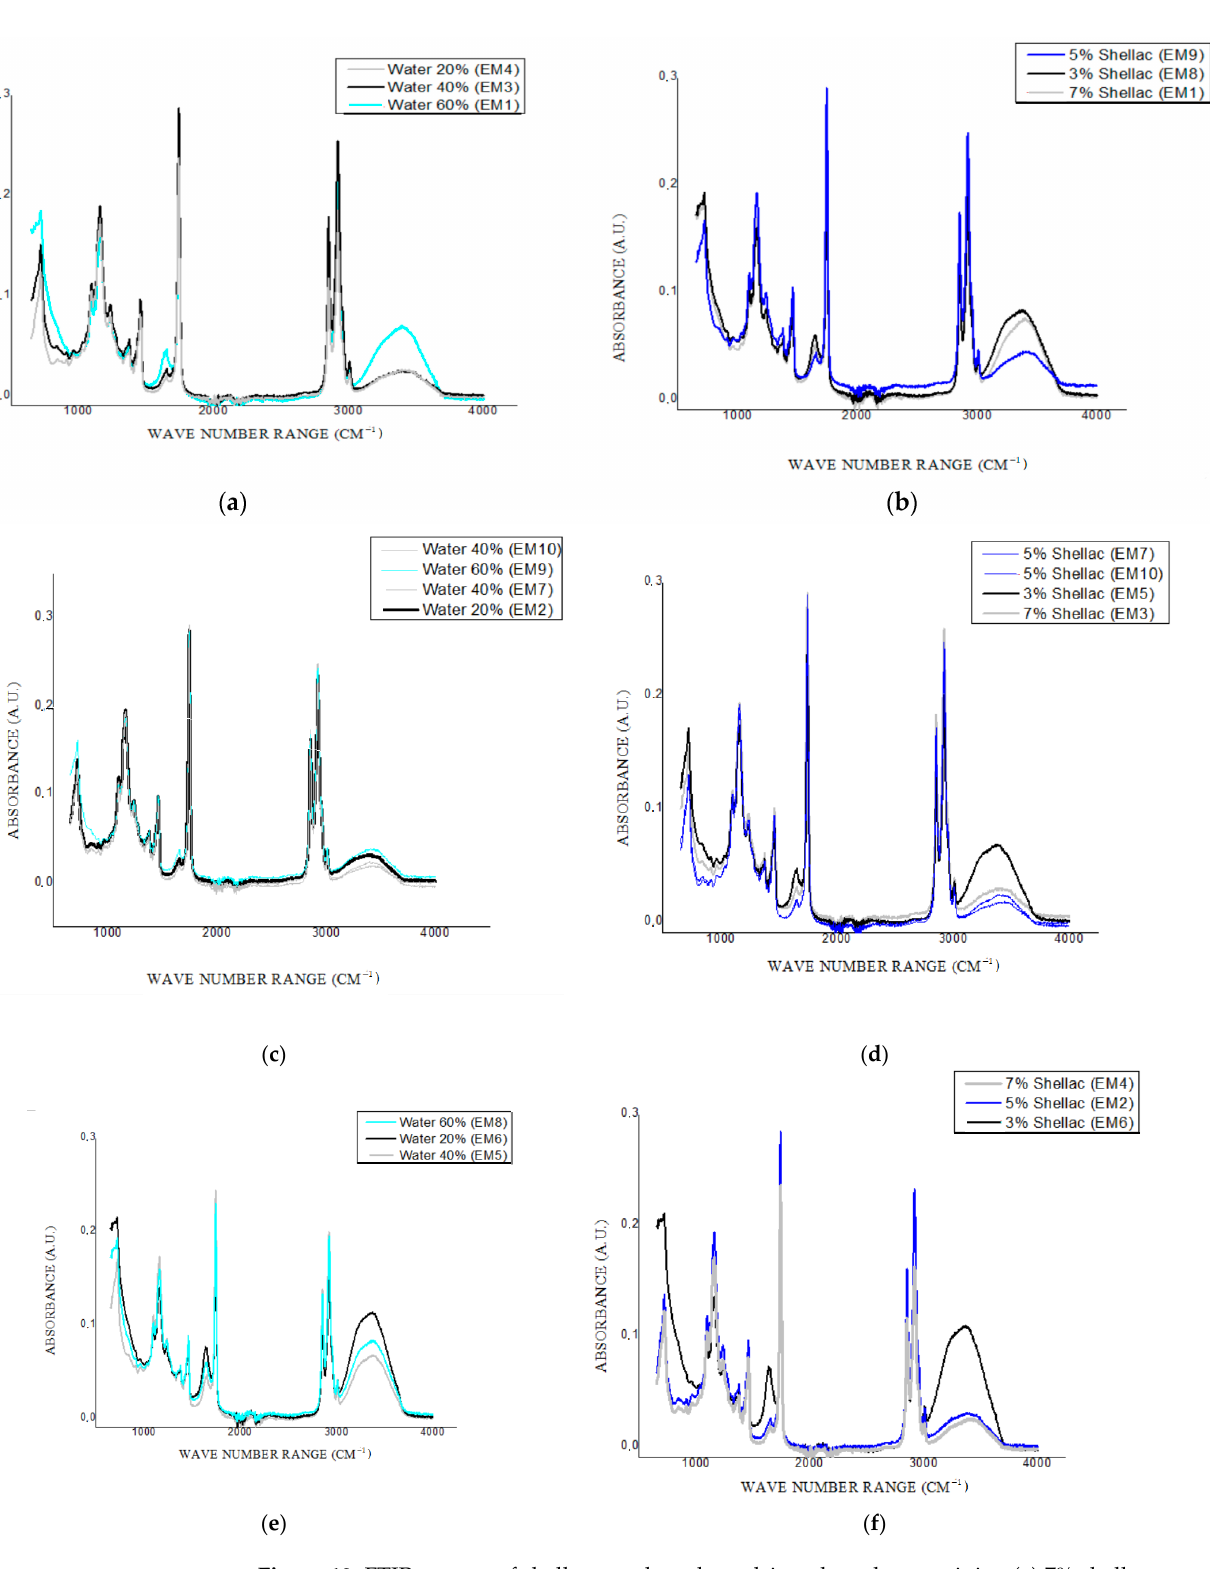
Figure 10. FTIR spectra of shellac wax-based emulsion oleogels, containing ( a ) 7% shellac wax and various water concentrations (20–60%), ( b ) 60% water and various shellac concentration (3–7%), ( c ) 5% shellac wax and various water concentration (20–60%), ( d ) 40% water and various shellac concentration (3–7%), ( e ) 3% Shellac wax and various water concentration (20–60%), and ( f ) 20% water and various shellac concentration (3–7%).